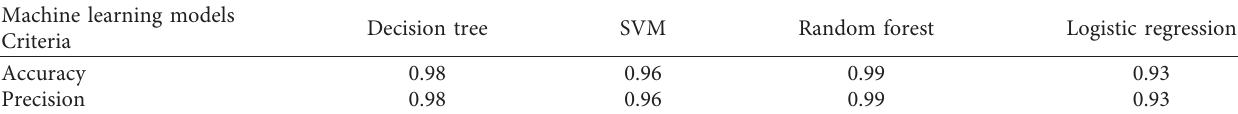
Table 2: Comparison of machine learning models using principal component analysis features.